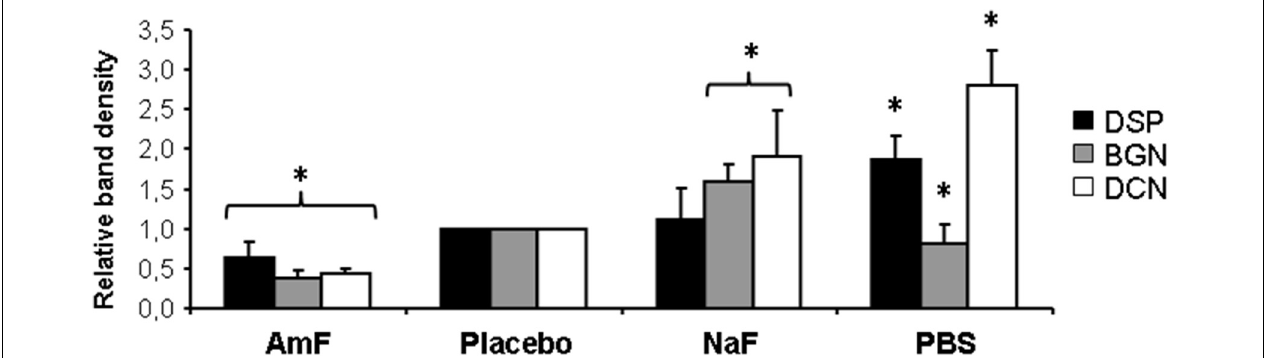
FIGURE 2 | Quantification of NCP release from Western blot analysis. QuantificationofthedifferentbandsbyImageJafternormalizationwithplacebo bands shows a significant weaker protein release in samples pre-treated with